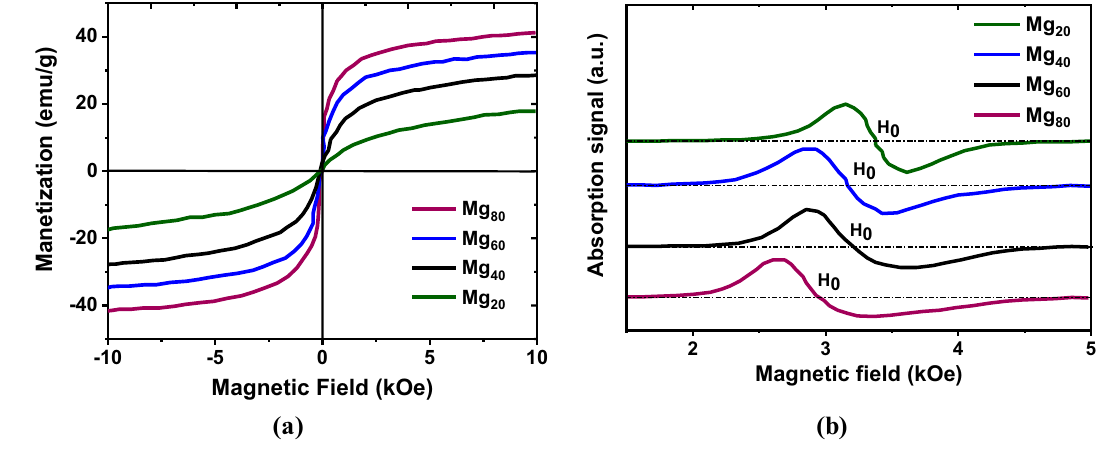
Figure 9. ( a ) Comparison of magnetization versus magnetic field (M–H) hysteresis loops and ( b ) ferromagnetic resonance (FMR) spectra of Mg–Zn ferrite